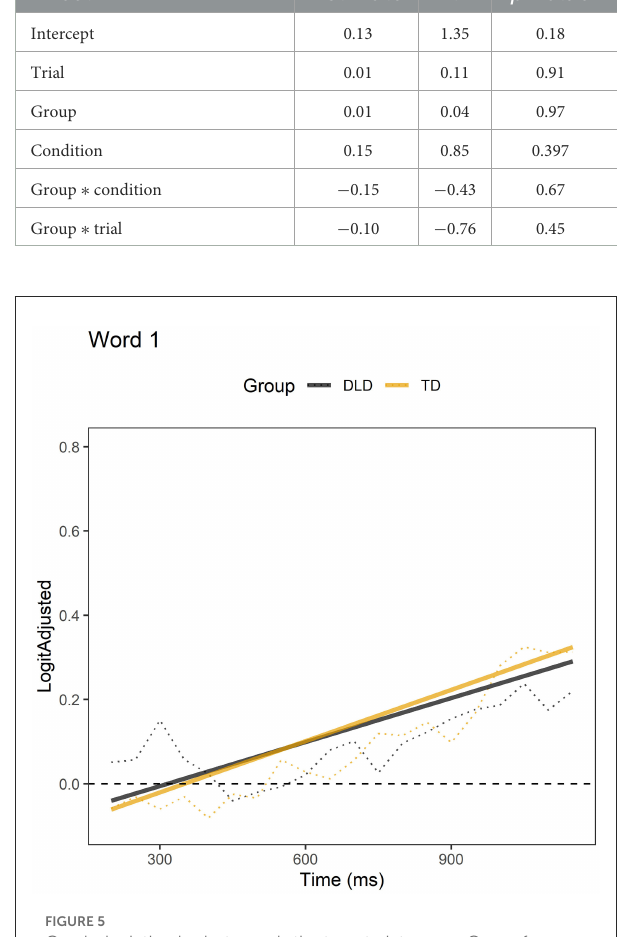
FIGURE5 Graph depicting looks towards the target picture per Group for Word1. The dotted line represents the actual data, the solid line represents the prediction of the statistical